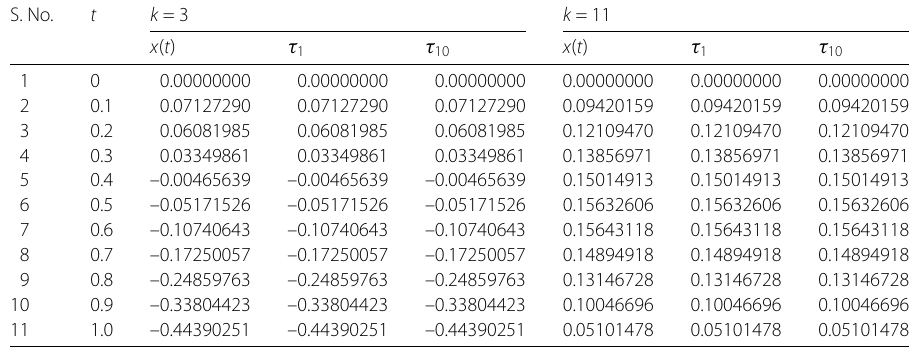
Table 4 Comparison between exact solution and approximate solution by using the JF iteration process for k = 3 and k = 11 S. No.